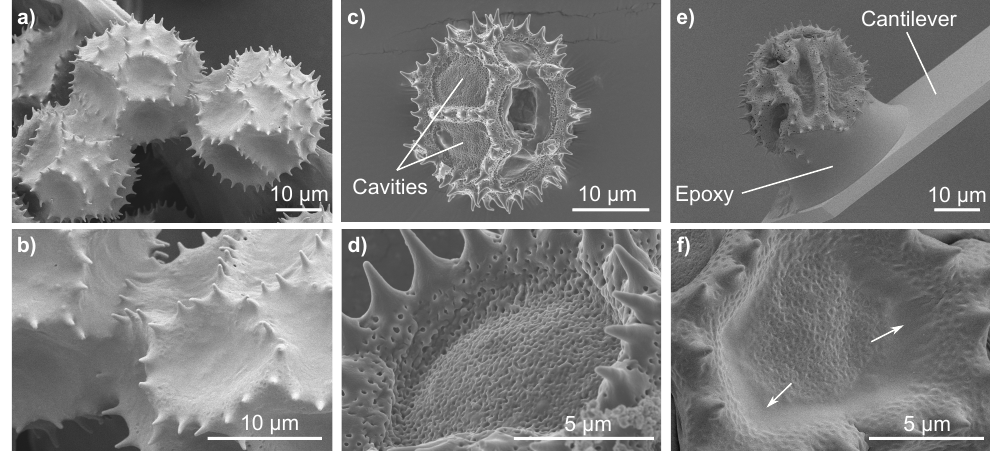
Figure 1. Cryo-scanning electron microscopy (cryo-SEM) images of fresh Hypochaeris radicata pollen with pollenkitt present ( a , b ) and with pollenkitt removed ( c , d ) as well as 7-day-old H. radicata pollen ( e , f ). The white arrows in ( f ) indicate remnants of pollenkitt on the surface of aged pollen. The influence of the pollen’s aging and dehydration process on the pollenkitt are clearly visible. In ( e ), a pollen glued to an atomic force microscopy (AFM) cantilever is presented, showing that the pollen grain surface is left pristine by the gluing